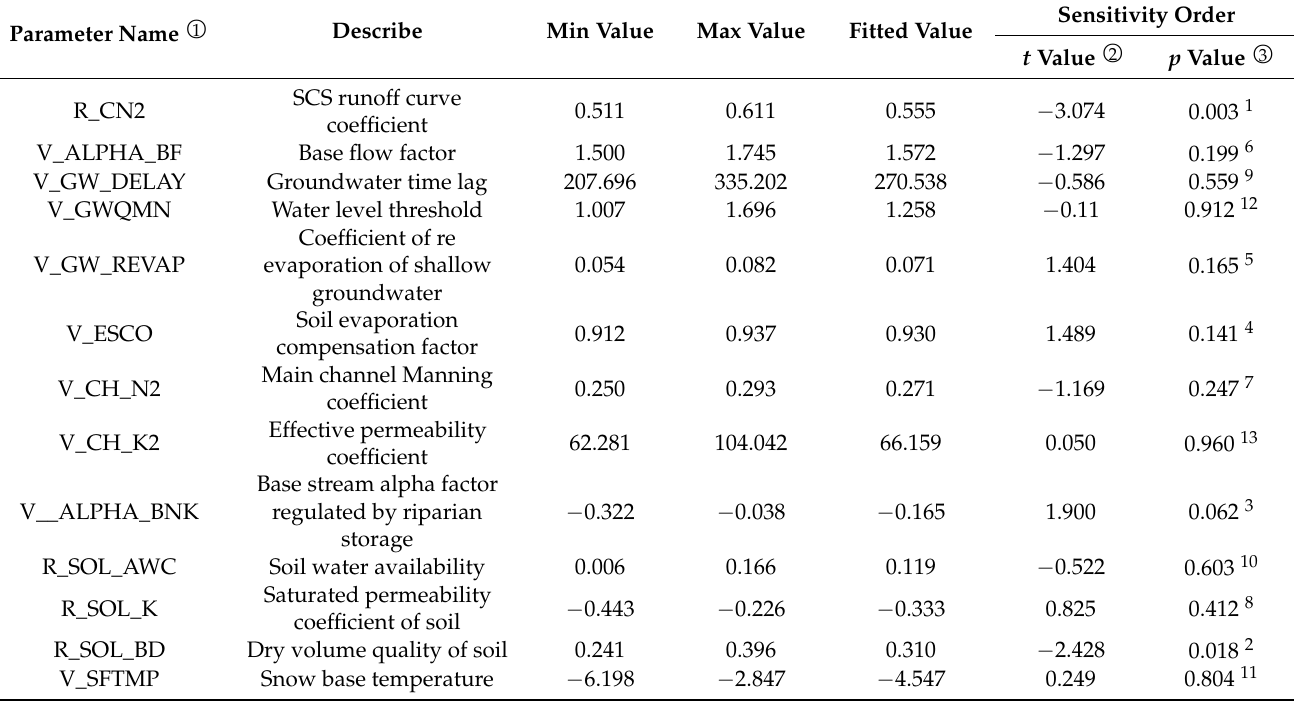
Table 2. Results of parameter sensitivity analysis.